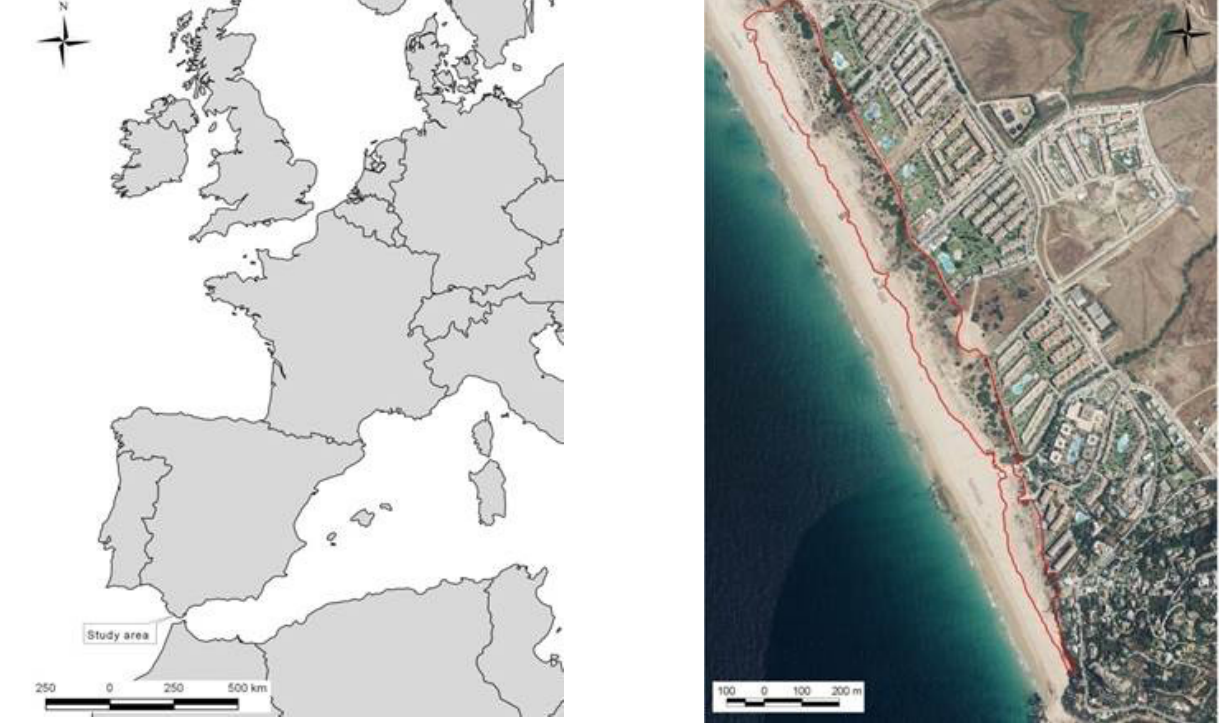
Figure 1. Study area. Left: Location. Right: Delimitation on orthophoto